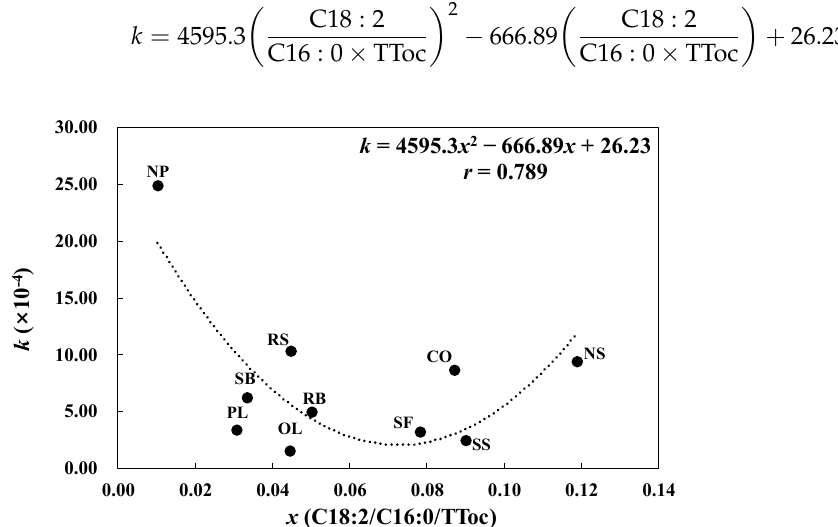
Figure 2. Relationship between k and the initial composition of oil during frying. k is the slope of the change in carbonyl value with the change in the peak area of pentanal and x represents the ratio of the initial contents of linoleic acid to that of palmitic acid and total tocopherols.